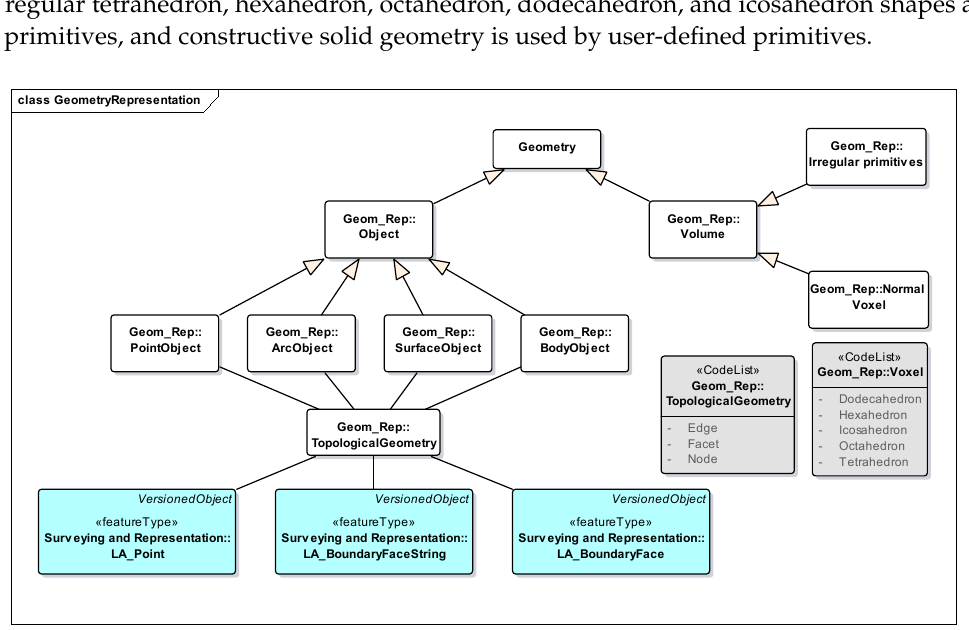
Figure 19. Physical layer of the natural resource class.